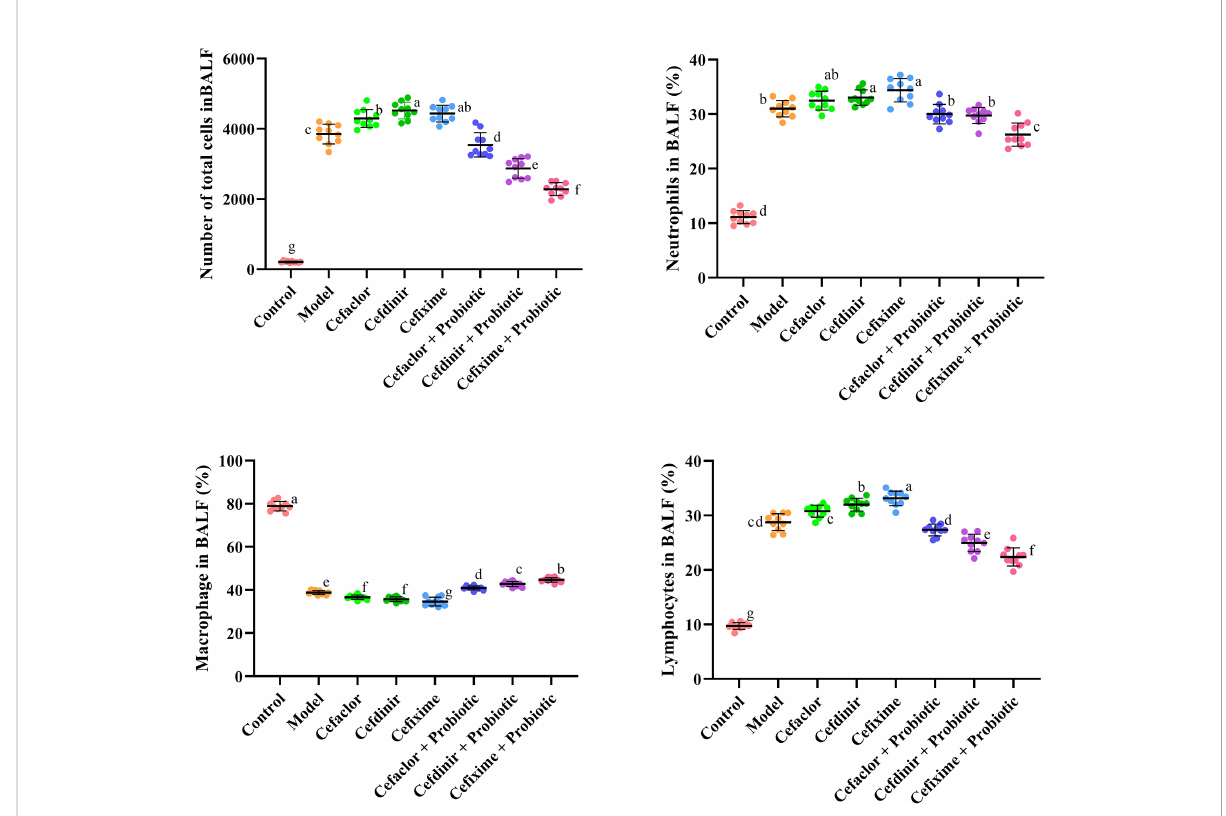
FIGURE 3 Effects of cephalosporins on the recruitment of in fl ammatory cells in the BALF of Spn-infected mice. Data were showed as mean ± SD. Different letters indicated statistically signi fi cant differences, P